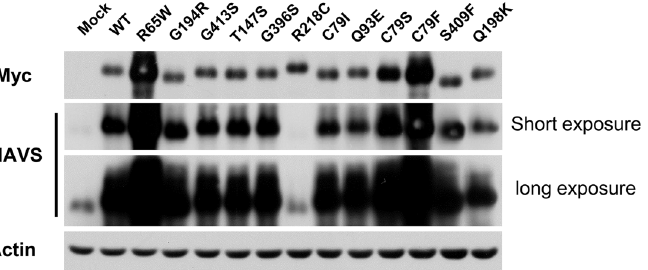
Fig 2. Influence of SNPs on MAVS protein. HeLa cells were transfected with an empty plasmid (mock) or a plasmid encoding WT or variant MAVS and were then incubated for 24 h. Cell extracts were subsequently subjected to SDS-PAGE and blotted with anti-MAVS or anti-Myc antibody. The results are representative of three independent experiments.